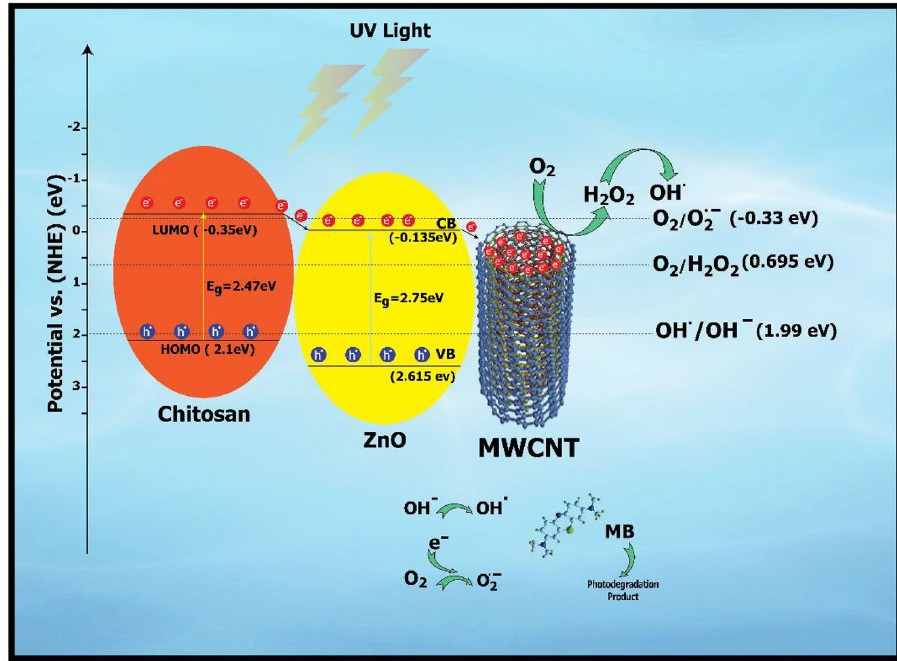
Figure 15. Schematic diagram of proposed photocatalytic mechanism by separation of photo-produced charge carriers in MWCNTs/ZnO/Chitosan ternary